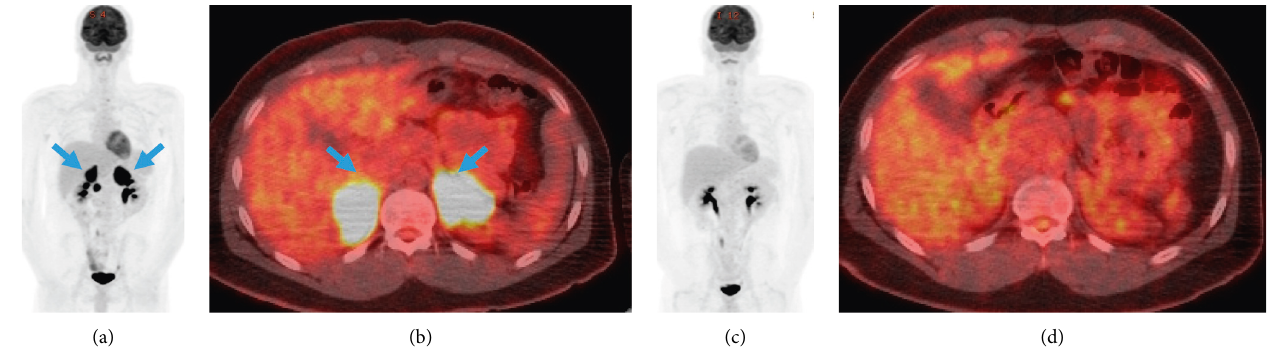
Figure 5: Pretreatment coronal maximum-intensity-projection (a) and axial fused FDG-PET (b) images show enlarged and hypermetabolic bilateral adrenal glands (blue arrows) with SUV max of 17.1 and 14.1 on the right and left respectively. Posttreatment coronal maximum- intensity-projection (c) and fused axial FDG-PET (d) images show resolution of previously seen hypermetabolic activity of bilateral adrenal glands two months following CAR-T. Table 1: Current CAR-T clinical trials in R/R